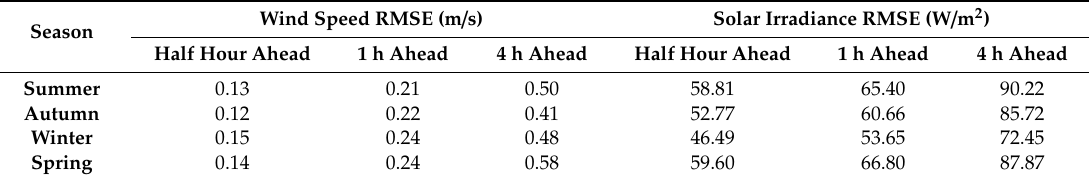
Table 8. E ff ectiveness of proposed model in di ff erent time horizons.